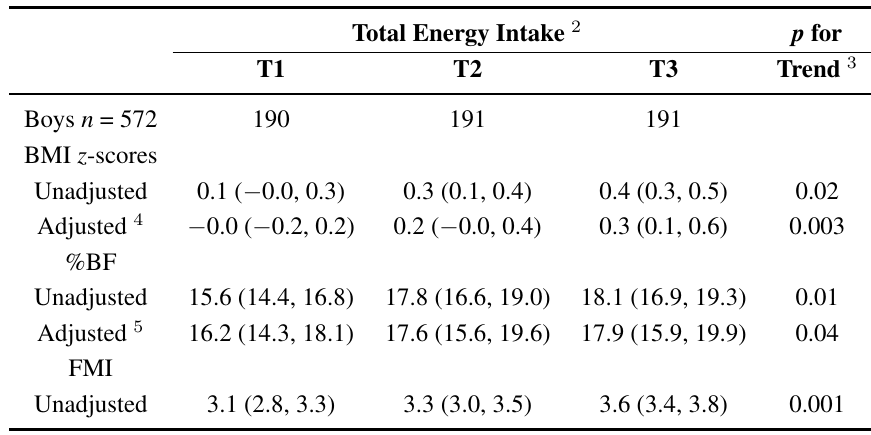
Table 2. Association of total energy intake with BMI z -scores, %BF, FMI, FFMI and WHR among children aged 8–14 years 1